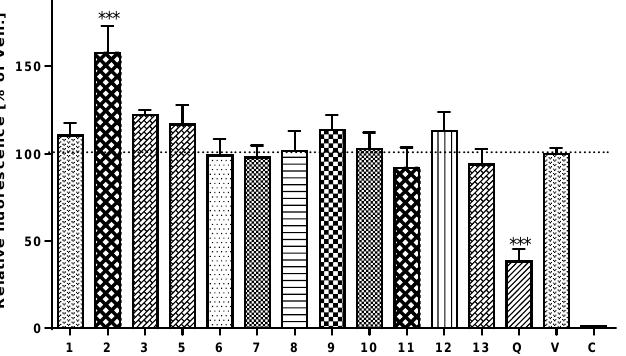
Figure 5. Effect of selected E. globulus compounds on the production of ROS. THP-1 monocytes were pre-treated with compounds 1 – 3 , 5 – 12 , and 13 ( a + b ) at concentrations of 5 μM, with 1 μM quercetin (Q) or with only the vehicle (V) for 30 min. Pyocyanin at a final concentration of 100 μM was then added (to all but C, control cells) to trigger the generation of ROS. After 30 min, DCFH-DA (5 µ g/mL) dissolved in DMF was introduced into the cell medium. The intracellular fluorescence of dichlorofluorescein produced in this oxidative reaction was measured spectrophotometrically. The results in Figure 5 show the mean ± SE for three independent experiments. *** indicates a significant difference ( p < 0.001) in comparison with the vehicle-treated cells.